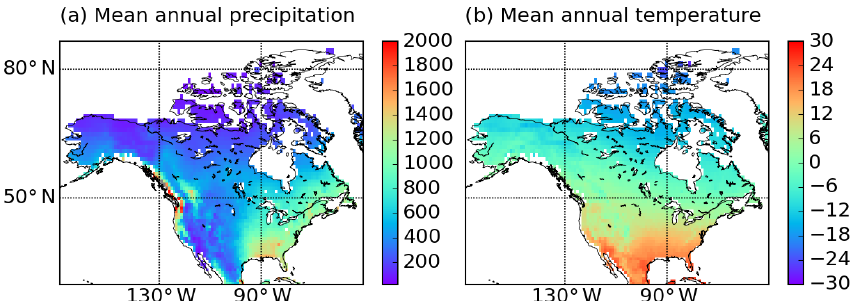
Figure 1. Spatial distribution of mean annual (a) precipitation (mm) and (b) temperature ( ◦ C) across North America. Grid cells with perma- nent ice/glaciers have been masked